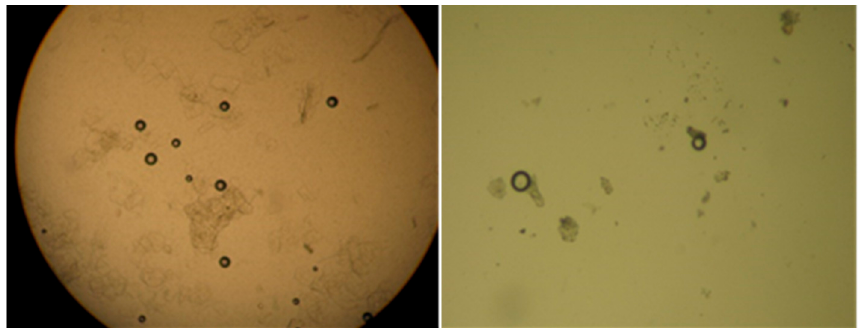
Figure 3. Leica microscopic image of niosomes at 10× and 40×.